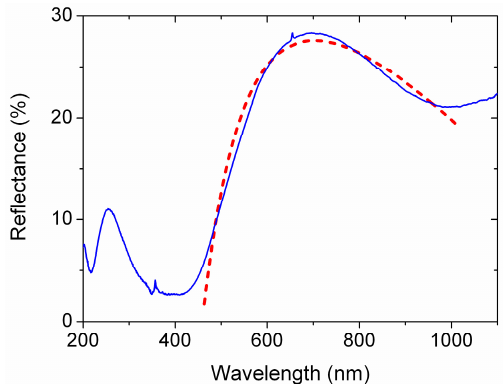
Figure 4. Spectrum of a pyrolyzed ink-jetted SDP-Y 2 O 3 film on unpolished SS tape obtained by Figure 4. Spectrum of a pyrolyzed ink ‐ jetted SDP ‐ Y 2 O 3 film on unpolished SS tape obtained by Figure 4. Spectrum of a pyrolyzed ink ‐ jetted SDP ‐ Y 2 O 3 film on unpolished SS tape obtained by reflectometry. The solid blue line is the measured experimental spectrum, while the dashed red line is reflectometry. The solid blue line is the measured experimental spectrum, while the dashed red line reflectometry. The solid blue line is the measured experimental spectrum, while the dashed red line Figure 4. Spectrum of a pyrolyzed ink ‐ jetted SDP ‐ Y 2 O 3 film on unpolished SS tape obtained by is the theoretical fitting provided by the software. the theoretical fitting provided by the software. is the theoretical fitting provided by the software. reflectometry. The solid blue line is the measured experimental spectrum, while the dashed red line is the theoretical fitting provided by the software.